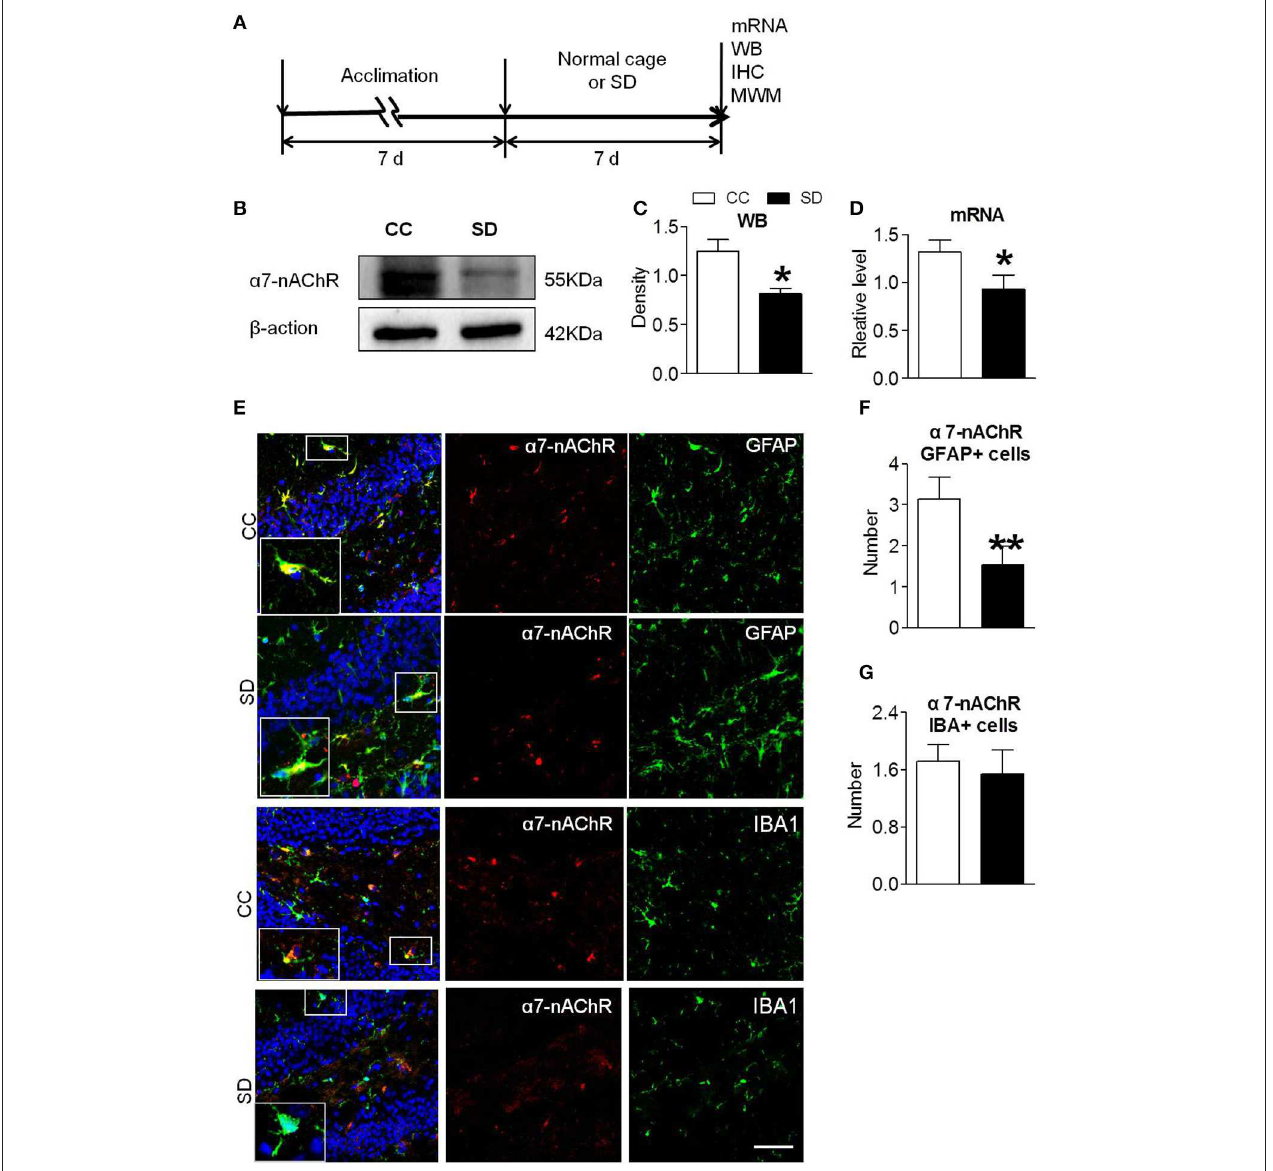
FIGURE 1 | Down-regulated α 7-nAChR expression in mice hippocampus after chronic sleep deprivation. (A) Schematic diagram depicting the experimental procedures. Before sleep deprivation, the mice in SD group was adapted to the environment in the modified multiple platforms for 7 days, 2h per day. All mice were housed with 12h light/dark cycles during the experiment and were operated on after sleep deprivation at 9a.m. (B,C) Western blots of α 7-nAChR in hippocampus, compared to control group, chronic sleep deprivation for 7 days significantly decreased expression of protein α 7-nAChR in hippocampus (* p < 0.05). (D) Chronic sleep deprivation for 7 days significantly decreased mRNA expression of α 7-nAChR in hippocampus. (E–G) Immunofluorescence staining of α 7-nAChR and quantitation of α 7-nAChR with glail cells. Less α 7-nAChR/GFAP + and α 7-nAChR/IBA + cells were observed in SD group compared with CC group. The scale bar represents 50mm. The results are expressed as mean ± SEM,* P < 0.05, ** P < 0.01, vs. control group. CC, Cage control; SD, sleep deprivation.